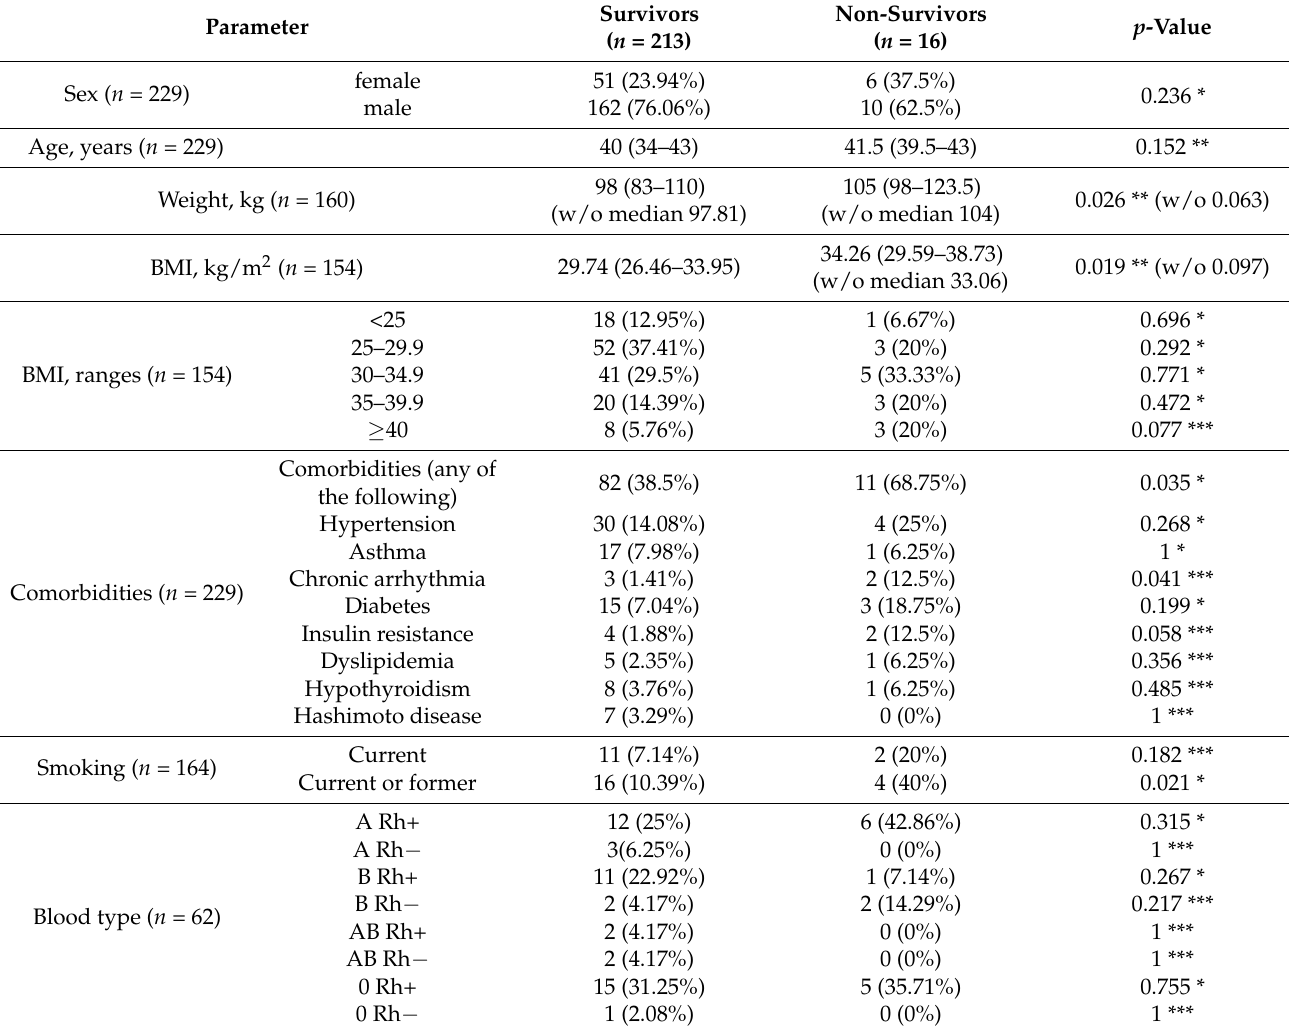
Table 4. Comparison of general patients’ characteristics between survivors and